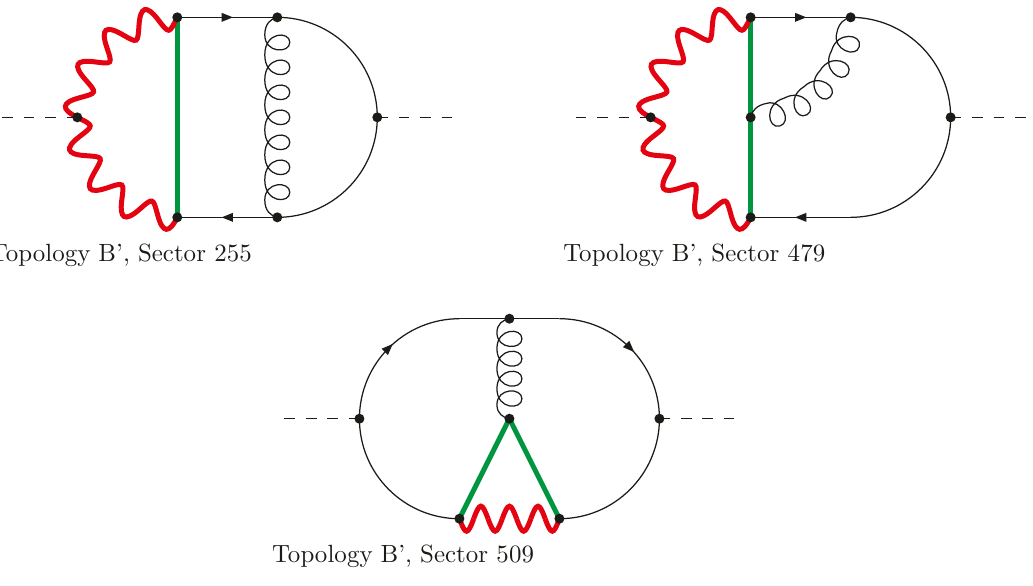
Figure 3 . Examples of additional three-loop Higgs self-energy diagrams containing a top propagator and a W -propagator and not being proportional to the product of Yukawa couplings y b y t . The internal masses of the propagators are encoded by the colour of the propagators: massless (black), m t (green), m W